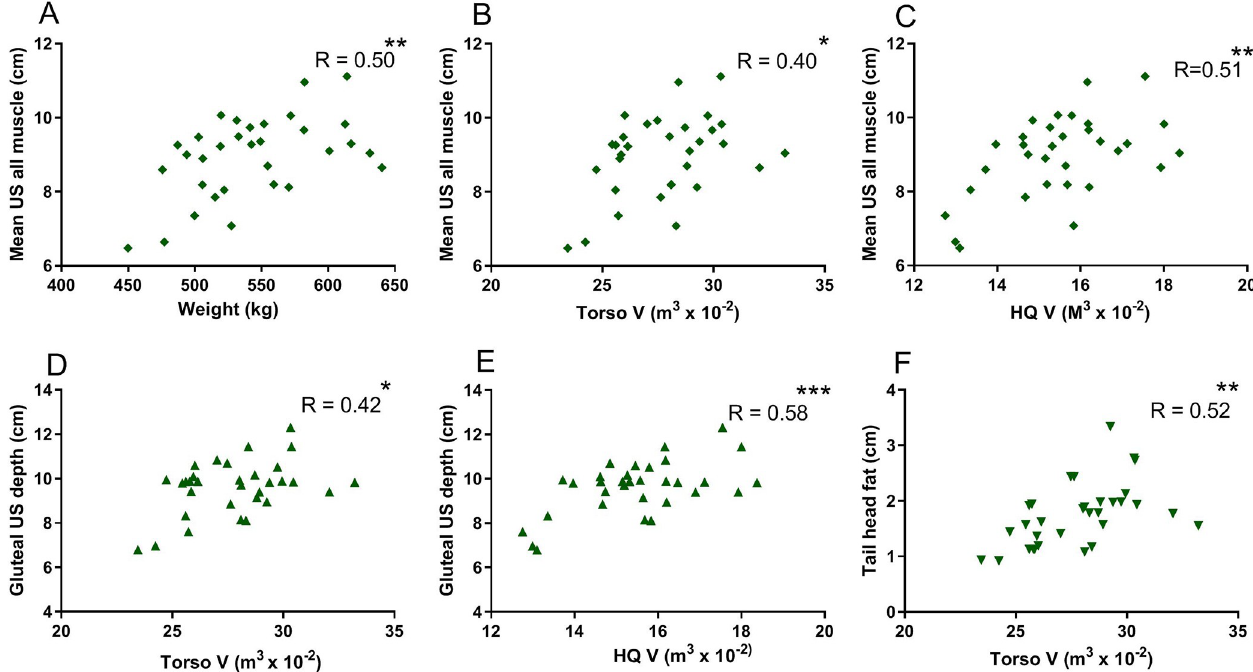
Fig 4. Correlation and Pearson’s correlation coefficients. A. Mean US measures of two sites in lumbar muscle and one site over the middle gluteal muscle compared to body weight. B. Mean US values for the three muscle depths compared to torso V. C. Mean US values for the three muscle depths compared to hindquarter (HQ) V. D. Positive correlation of middle gluteal ultrasound depth with torso V. E. Positive correlation of middle gluteal ultrasound depth with HQ V. F. Positive correlation of tail head fat to torso V. � P < 0.05, �� P < 0.01, ��� P < 0.001.